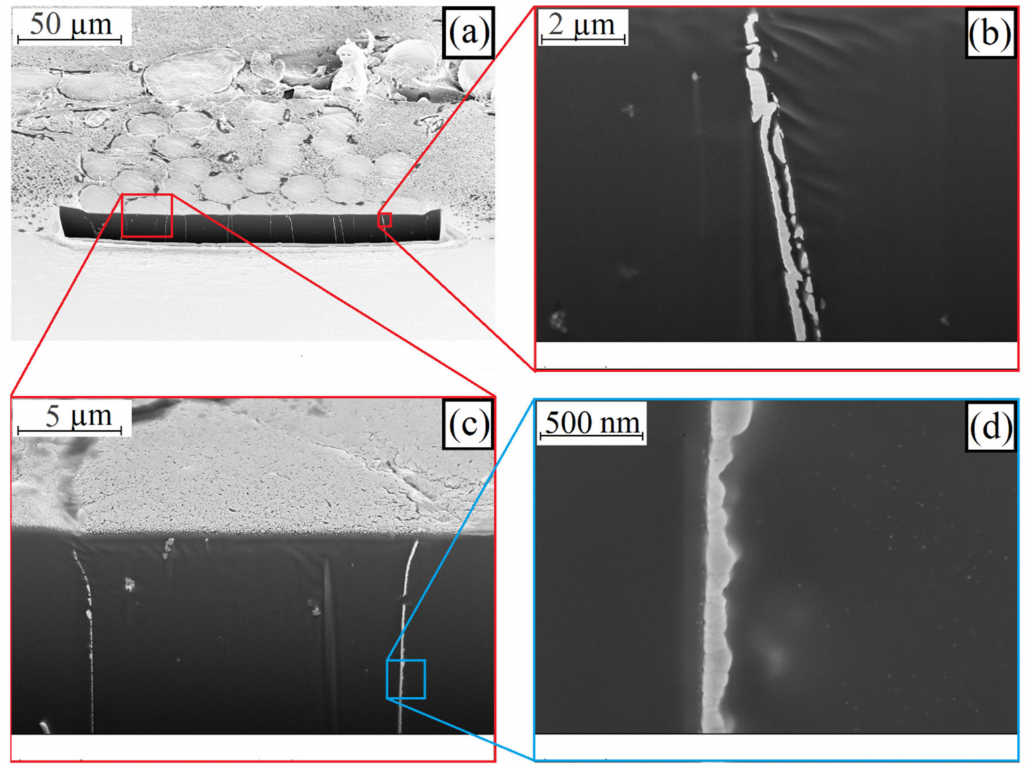
Figure 16. SEM image of a FIB cut on an untested sample with conductors made of knitted textiles at magnification of: ( a ) 500 × ; ( b ) 10,000 × ( c ) 4000 × and ( d ) 50,000 × .